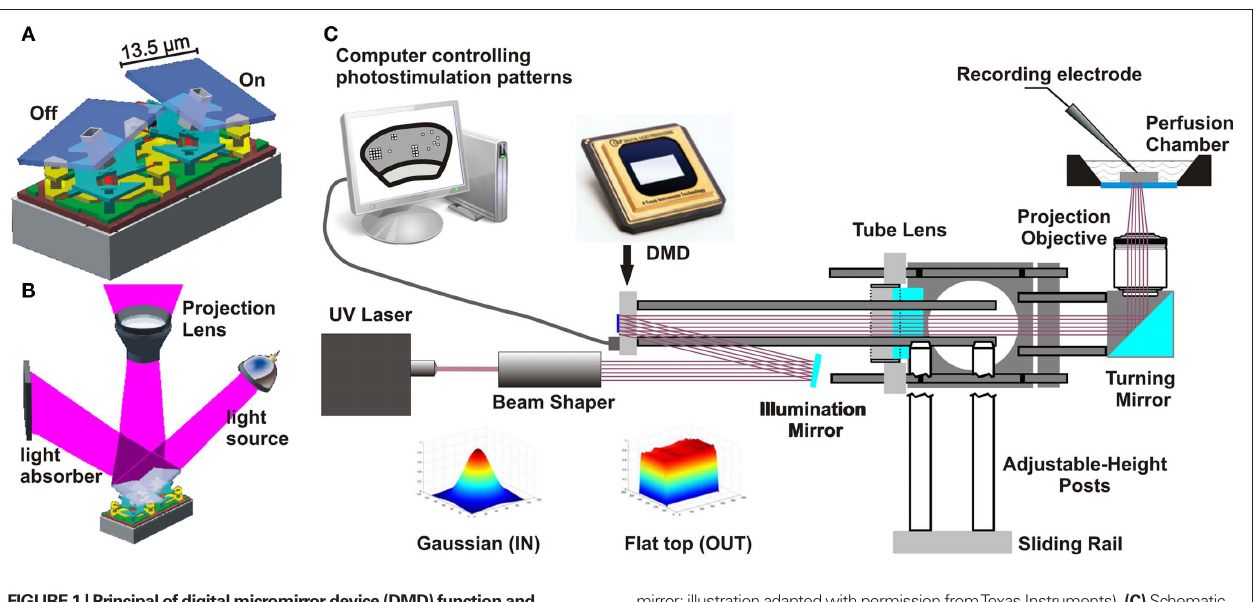
Figure 1 | Principal of digital micromirror device (DMD) function and integration of a DMD into the photostimulation light path. (A) Two DMD mirrors with one mirror (left) in the “off” and the other (right) in the “on” position (illustration adapted with permission from Texas Instruments). (B) Illustration of a two-mirror DLP system. Each micromirror reflects the light either toward the projection optics (left mirror in the bottom illustration) or toward a light absorber (right